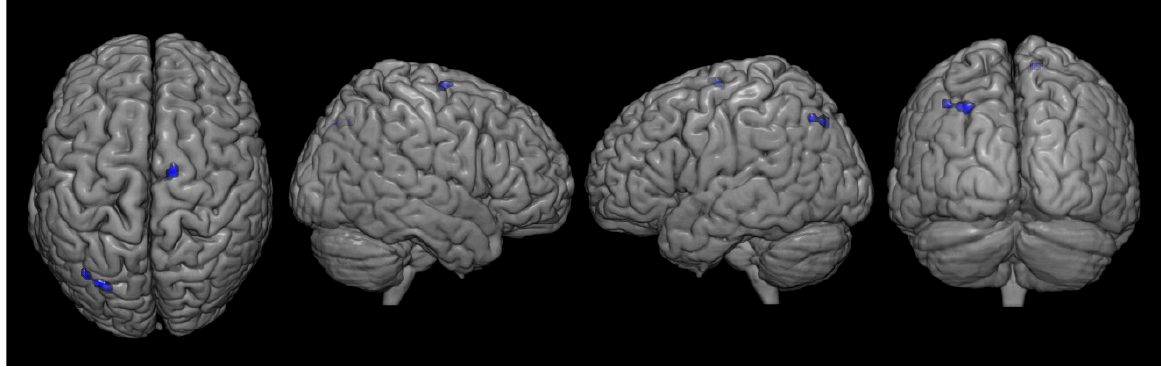
Figure 5. Statistical parametric maps demonstrating the regions with decreased pain intensity correlated with increased pain intensity. ( P uncorrected < 0.001, k = 10).